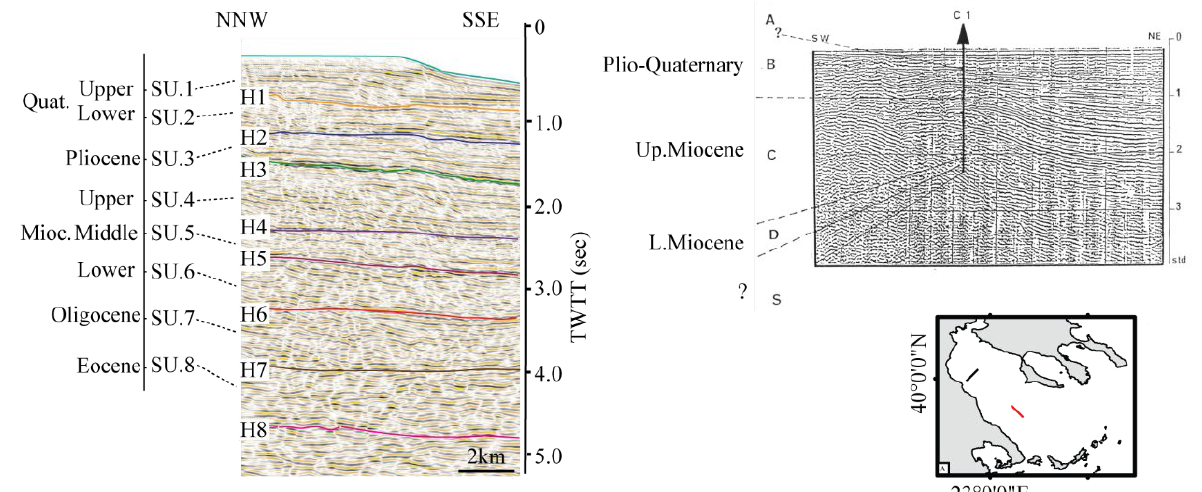
Figure 4. Left: seismic units’ distinction with picked horizons in part of the MN section (red line in map). Right: vintage seismic profile from north Thermaikos (black line in map) from IFP [38] correlated with well TH-C1.